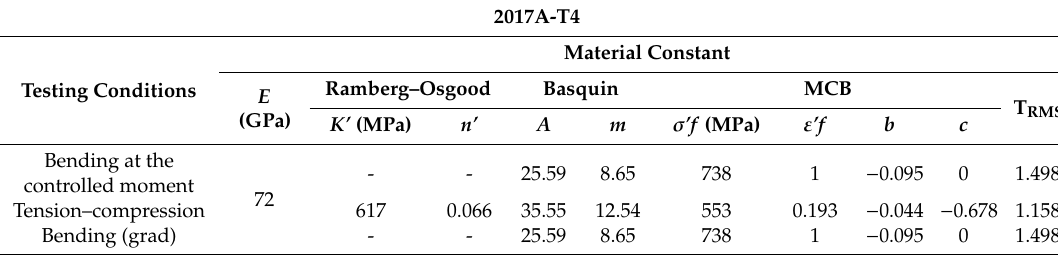
Table 8. Cyclic properties of 2017A-T4 aluminum